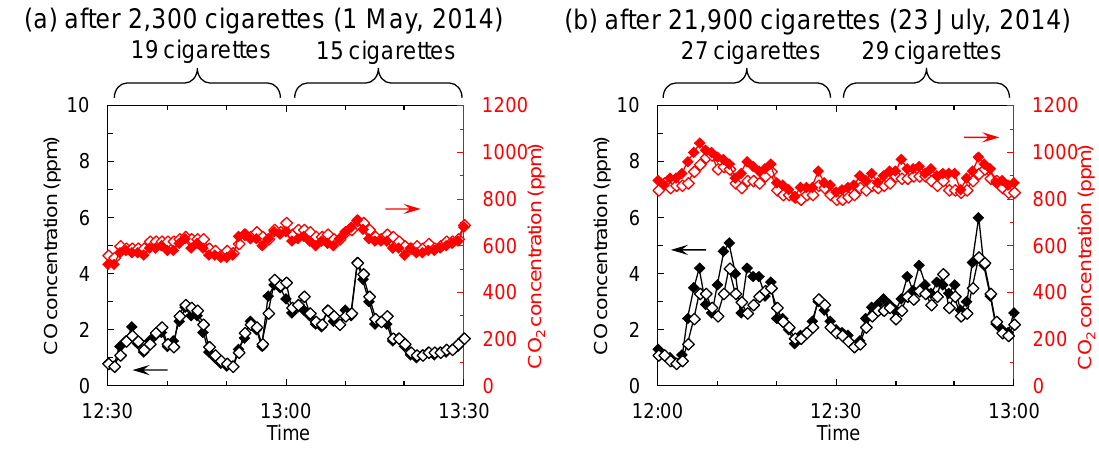
Figure 8. CO (black) and CO 2 (red) concentrations from the Figure 2 sampling points 1 (filled diamonds) and 2 (open diamonds) after the treatment of ( a ) 2300 and ( b ) 21,900 cigarettes-worth of tobacco